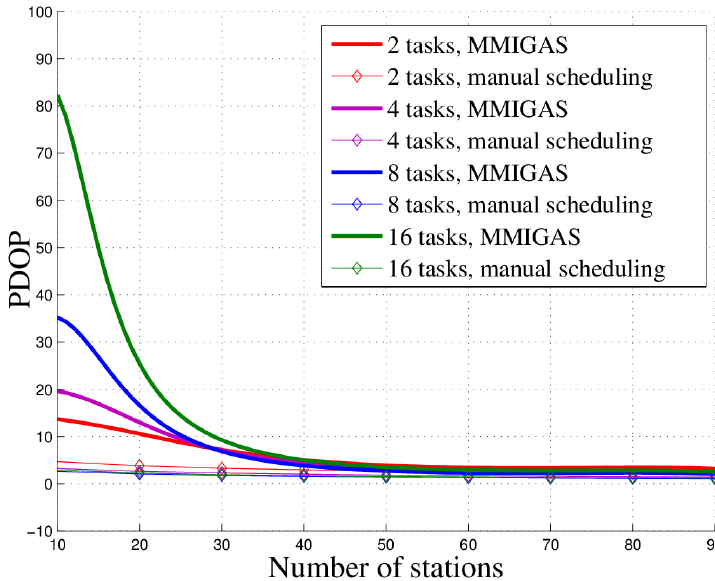
Figure 16. Position dilution of precision (PDOP) in different scenario.